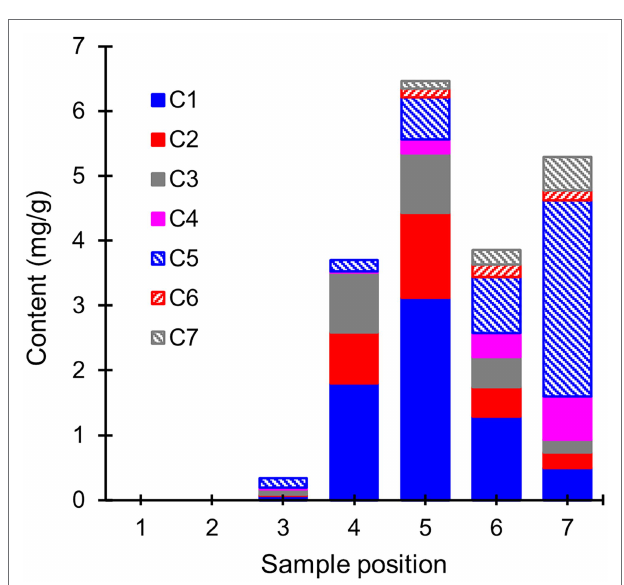
FIGURE 5 | Average contents (mg/g) of extractive degradation products (compounds C1–C7) in heartwood blocks exposed to R. placenta . Compounds C1–C3 were identified as hydroxylated stilbene derivatives, and compounds C4–C7 as tentative hydroxylated dehydroabietic acid derivatives. N =